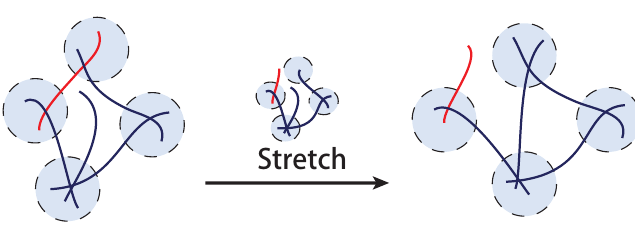
Figure 12. A sketch of a transient network where the filaments can be broken from, and re-crosslinked back to the network.